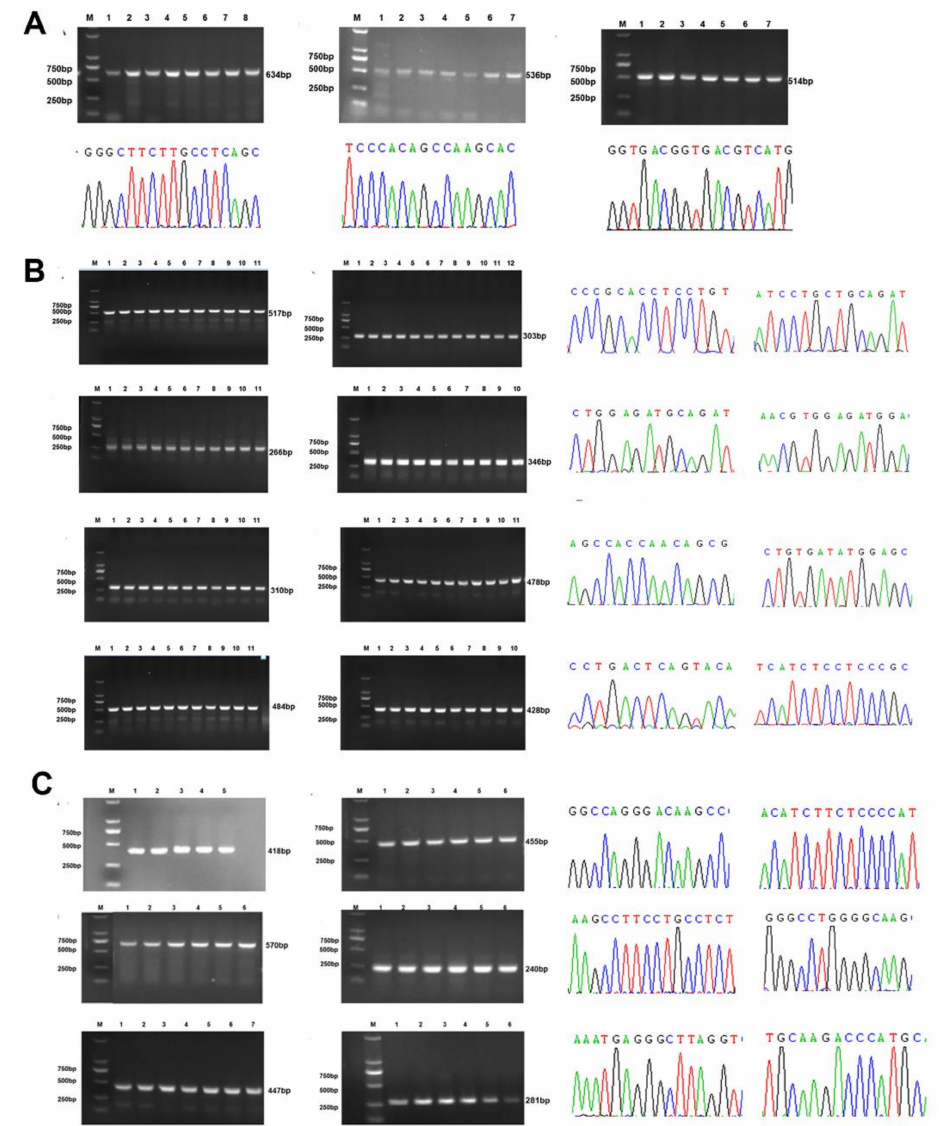
Figure 4. Polymorphism analysis of KRT17 promoter, exons, and introns from 217 Angora rabbits. Detection and sequencing results of KRT17 ( A ) promoter using primers 15–17; ( B ) exons using primers 1–8; and ( C ) introns using primers 9–14 (Table